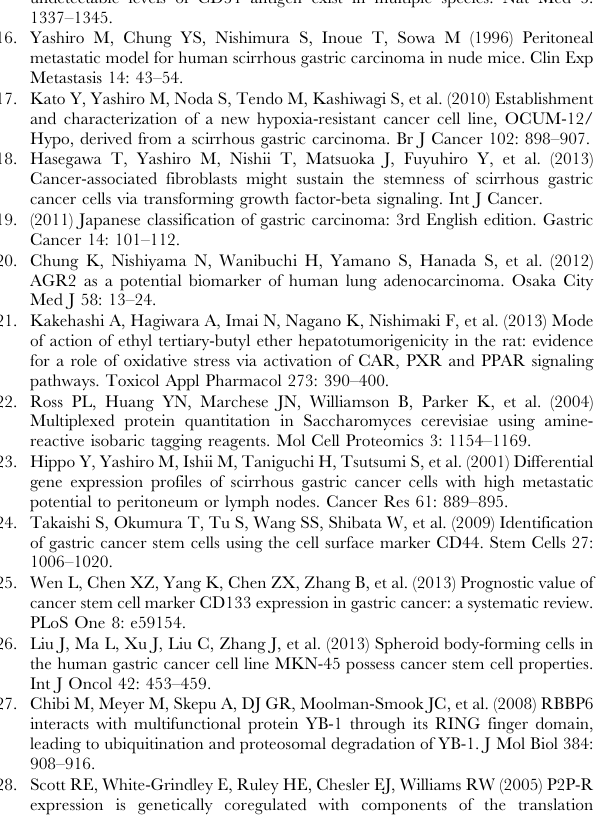
Figure S1 Representative picture of side population fraction. Cancer cells, which disappear in the presence of verapamil (lower panel), are outlined and defined as the SP cells. OCUM-12/SP and OCUM-2MD3/SP cells were sorted as SP cells from each of the parent OCUM-12 and OCUM-2MD3 cells, respectively. The percentages of SP cells were higher in the OCUM-12/SP and OCUM-2MD3/SP cells than in their parent